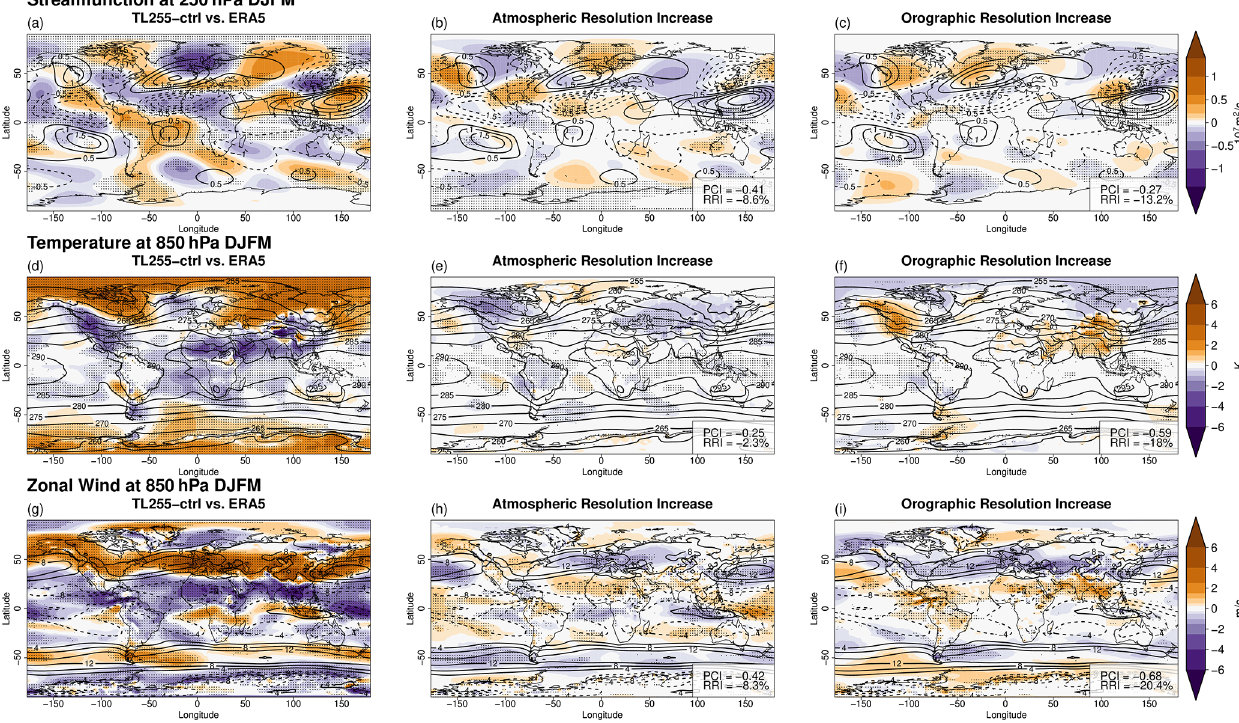
Figure 2. DJFM mean asymmetric component of the 250hPa streamfunction (a–c) , 850hPa air temperature (d–f) and 850hPa zonal wind (g– i) for (a, d, g) EC-Earth3 TL255-ctrl bias with respect to ERA5, (b, e, h) changes induced by the atmospheric resolution increase and (c, f, i) changes induced by the orographic resolution increase. Shading shows differences and contours the TL255-ctrl field. Please note the irregular colour-bar spacing. Stippling indicates significance with a Welch t test at the 1% level. In (b) , (c) , (e) , (f) , (h) and (i) the PCI and RRI (see text for details) are reported at the bottom right of each panel: large negative values imply reduced bias.